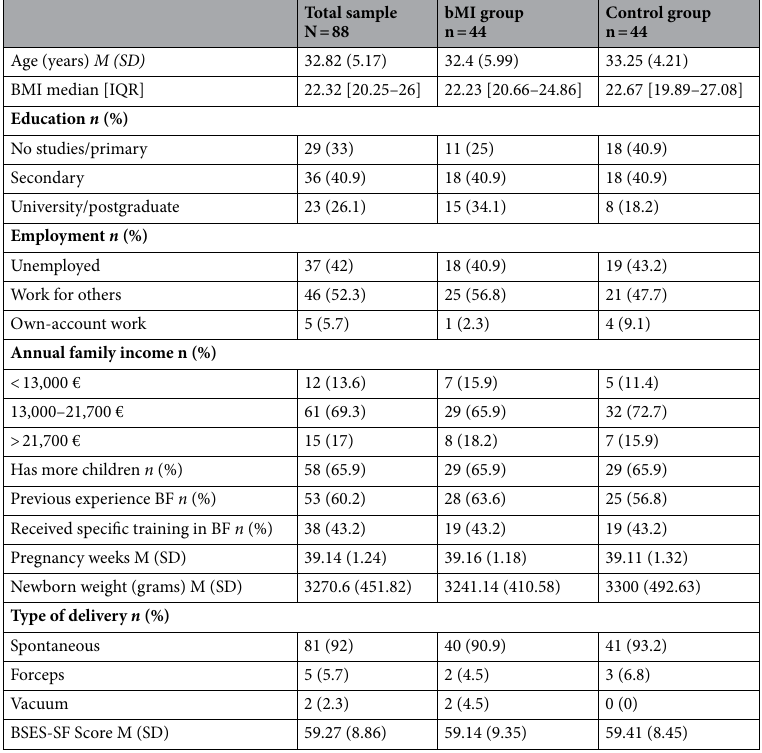
Table 2. Sociodemographic and clinical characteristics of the sample. M mean, SD standard deviation, IQR interquartile range, bMI brief motivational intervention, BF breastfeeding, BSES-SF Breastfeeding Self-Efficacy Scale Short Form, BMI body mass